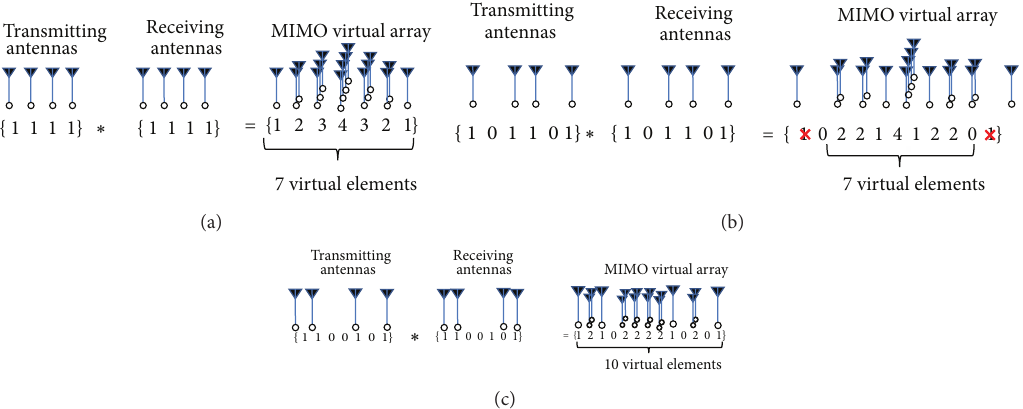
Figure 22: Illustration of examples of virtual arrays in MIMO radars: (a) uniform linear array, (b) truncated filled array, and (c) nonuniform